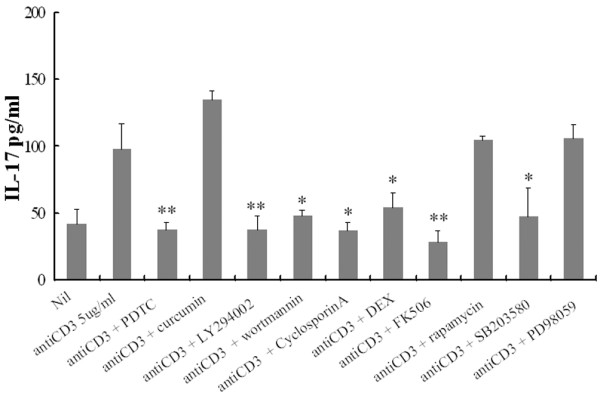
Effects of protein kinase inhibitors and anti-rheumatic drug on anti-CD3 triggered interleukin (IL)-17 production by peripheral blood mononuclear cells (PBMC) from patients with rheumatoid arthritis. PBMC pretreated for 1 hour with pyrrolidine dithiocarbamate (PDTC; 300 μM), curcumin (10 μM), LY294002 (20 μM), wortmannin (200 nM), Cyclosporin A (500 ng/ml), dexamethasone (DEX; 100 nM), FK506 (100 ng/ml), rapamycin (10 ng/ml), SB203580 (10 nM) or PD98059 (20 μM) in combination with anti-CD3 antibody (5 μg/ml). Culture supernatant was assayed for IL-17 as described in the Materials and methods section. Each value represents the mean and SEM of three independent experiments. *, P < 0.05; **, P < 0.005.